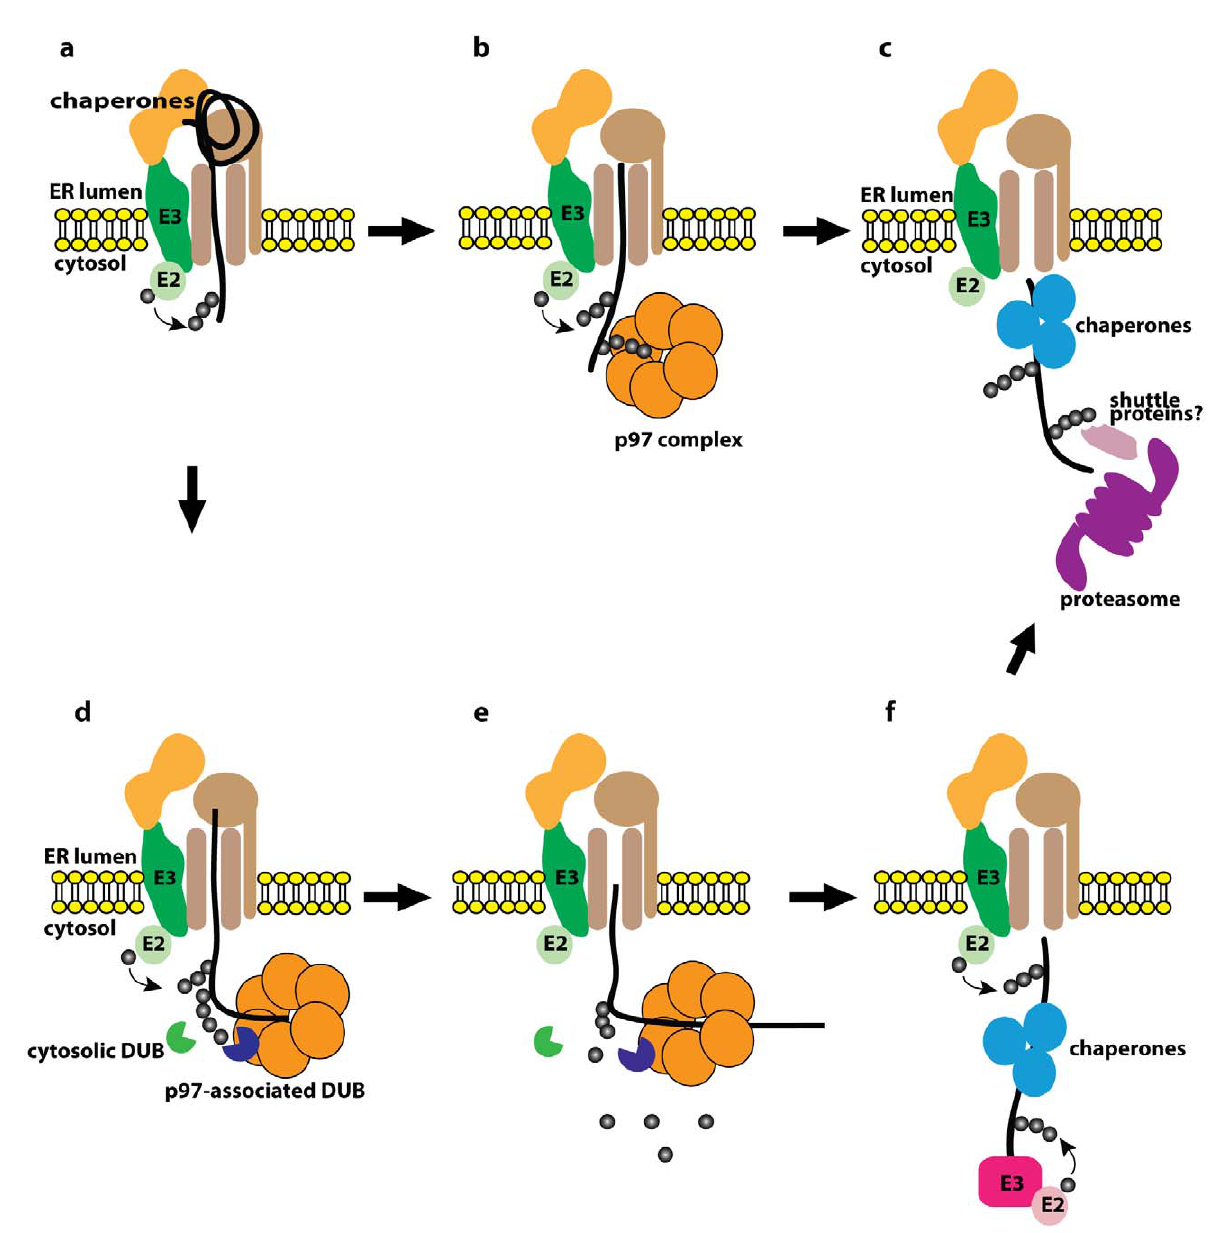
ubiquitin ligase (E3) and its cognate ubiquitin conjugating enzyme (E2) on the cytosolic face of the ER membrane. (b) The p97 complex, comprising a hexamer of the AAA ATPase p97 and accessory proteins such as Ufd1 and Npl4 (not depicted), associates with the retrotranslocation complex, recognizes the polyubiquitin chain and extracts the ubiquitylated substrate to the cytosol. (c) Polyubiquitin chains target the dislocated substrate to the 26S proteasome (magenta) for degradation, in some cases assisted by shuttle proteins (pink) that bind both to ubiquitin chains and